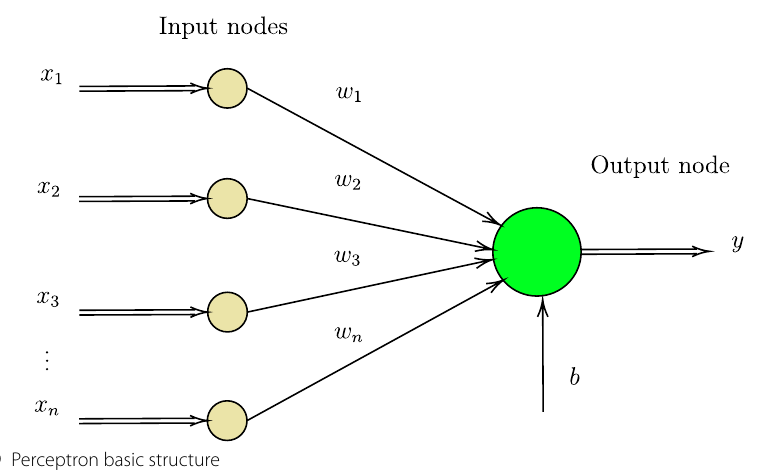
Fig. 9 Perceptron basic structure